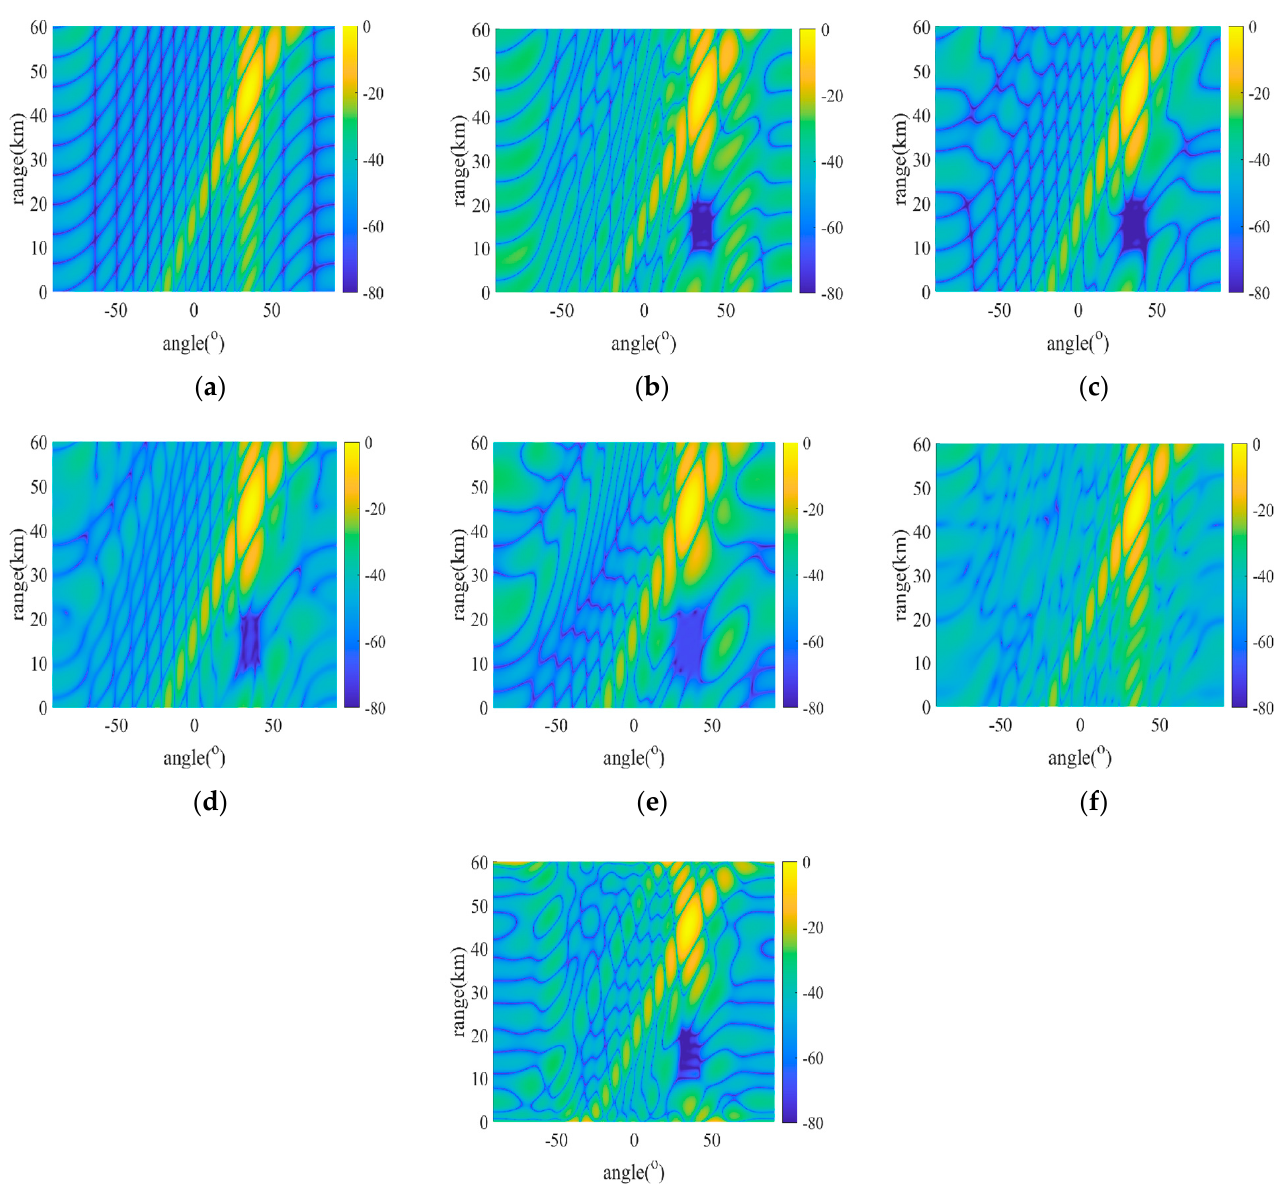
Figure 5. Two–dimensional beampattern of different methods when the swarm interference is distributed in an area. ( a ) Initial beampattern, ( b ) CMC, ( c ) CMD, ( d ) SNBC, ( e ) CNBC, ( f ) SMI- MVDR, and ( g ) INCMR-LCSS.